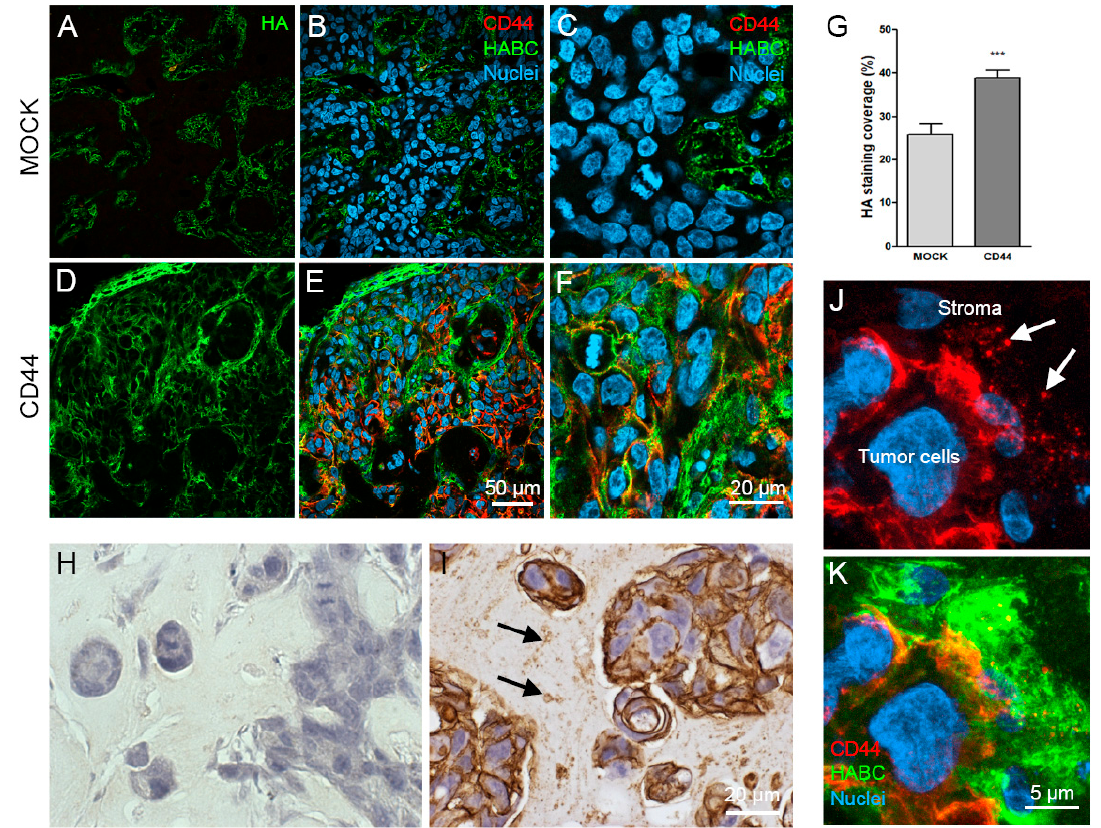
Figure 7. HA and CD44 content of CAM tumors. Confocal optical sections from CAM tumor paraffin sections derived from MOCK ( A – C ) and CD44-positive ( D – F ) cells, double-stained for HA ( A , D , green) and CD44 ( B , C , E , F , red, merged with green). The HA staining coverage visualized with DAB was analyzed from paraffin sections ( G ); n = 20 in both groups. CD44 (DAB, brown) staining of MOCK ( H ) and CD44-positive ( I ) tumors and superresolution 3D projections from CD44-positive tumors ( J , K ), double-stained with bHABC (green) and CD44 antibody (red). Arrows in ( I ) indicate the CD44-positive EVs in stromal area. *** p <